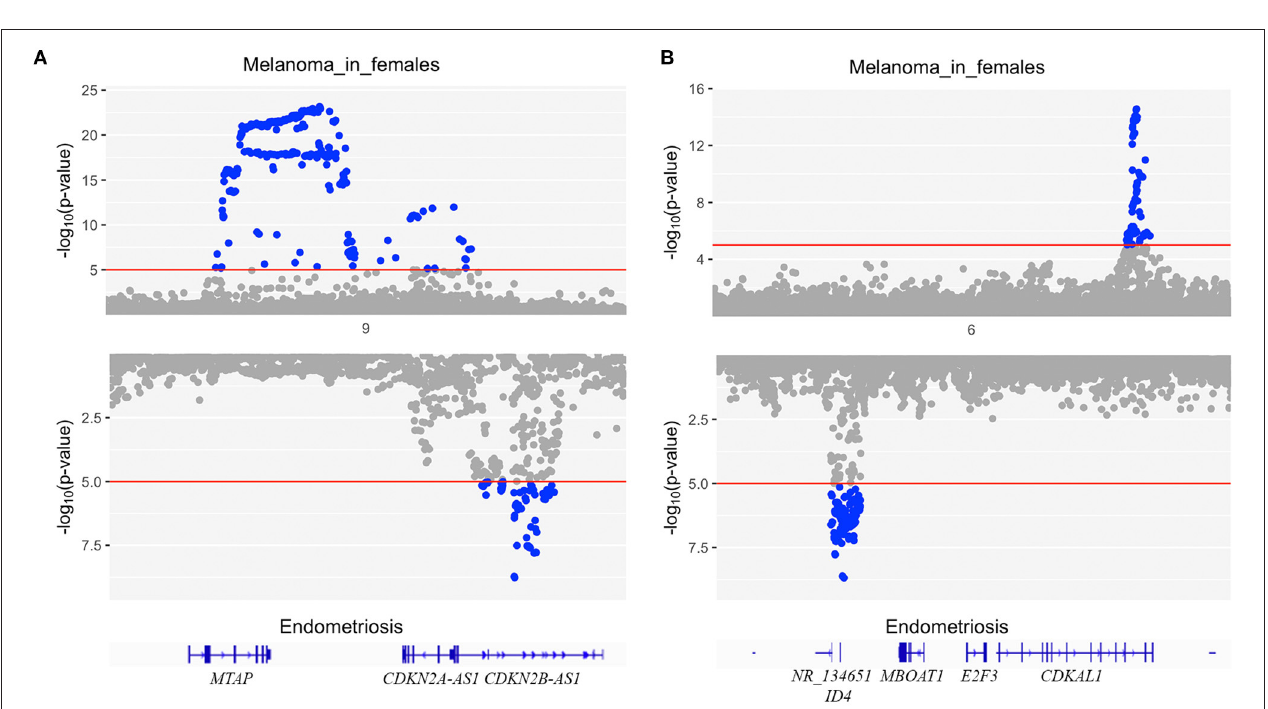
FIGURE 2 | Generalized summary-data based Mendelian randomisation (GSMR) results for melanoma in females and endometriosis. nSNPs, Number of SNP instruments; bxy, estimated effect of the exposure on outcome (bxy = bzy/bzx) where bzy represents the effect of SNP instrument on exposure on the logit scale and bzx represents its effect on outcome free of confounding effect from non-genetic factors.